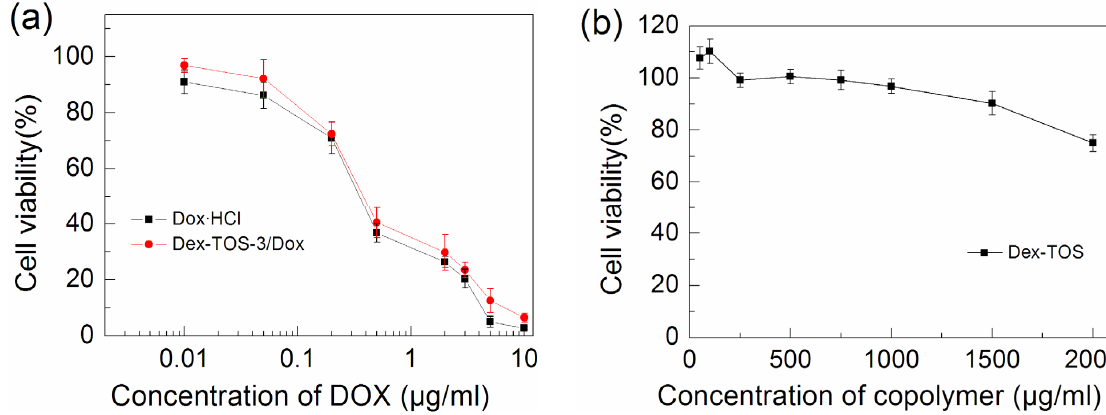
Figure 8. The cytotoxicity of ( a ) Dox·HCl, Dex-TOS-3/Dox micelles, and ( b ) blank Dex-TOS micelles against KB cells after 48 h incubation.